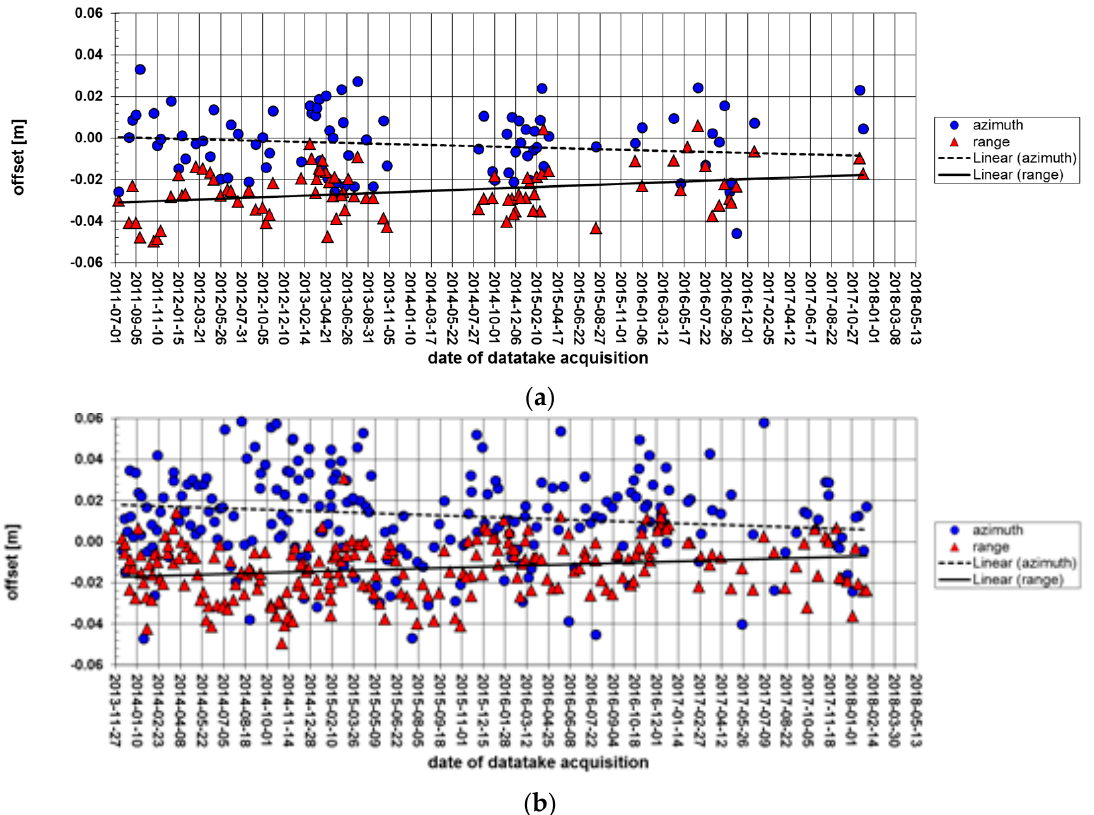
Figure 4. Temporal progression of the azimuth (blue) and range (red) offset obtained at the Wettzell test site: ( a ) Wettzell Ascending measurement series; ( b ) Wettzell Descending.